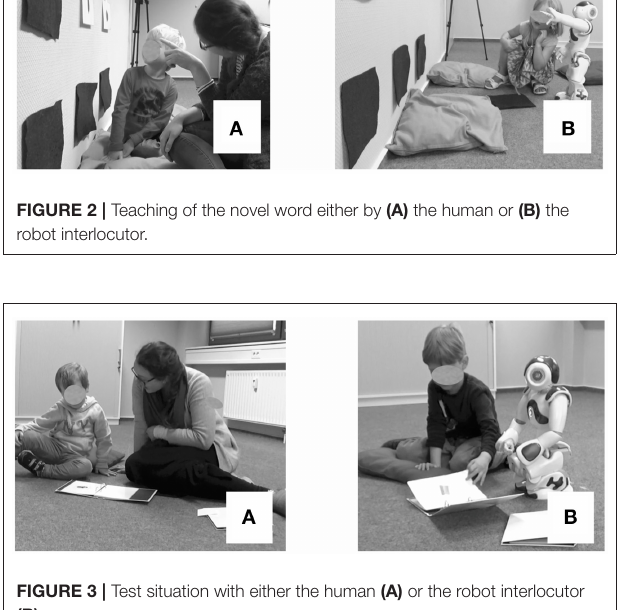
Horst, 2013; Nachtigäller et al., 2013). The referents of the